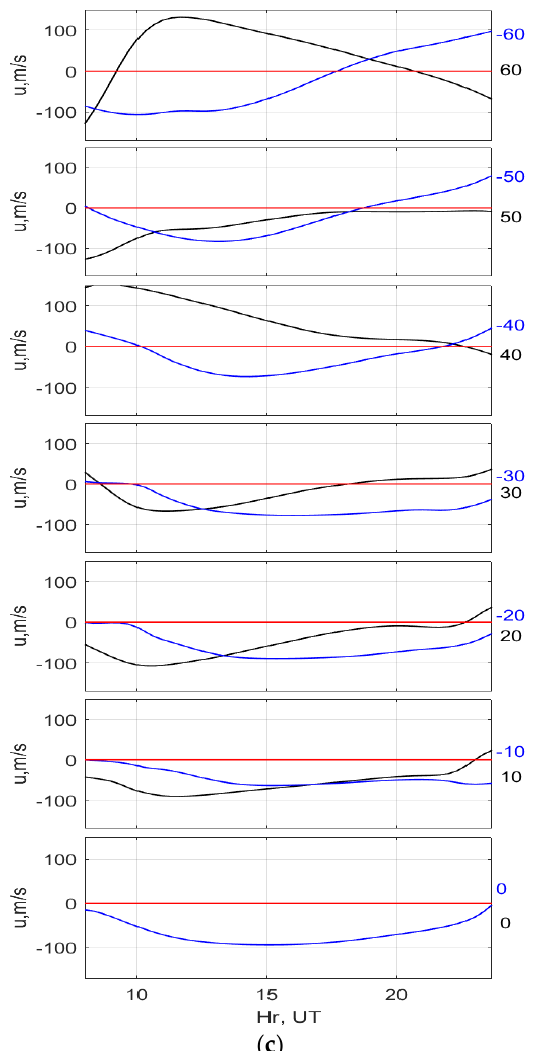
Figure 12. ( a ) Contour map for the meridional positive northward wind for both disturbed (top panel) and quiet (bottom panel) days. ( b ) TIEGCM result for 28 May 2017, showing meridional wind velocity changing from northward to southward geographically. ( c ) Same as ( b ) but in the magnetic meridian coordinate. The blue line represents the component of the wind in the south (0 to − 60 degrees), and the black line represents the component of the winds in the north (0 to 60 degrees). The positive value of the winds indicates northward.